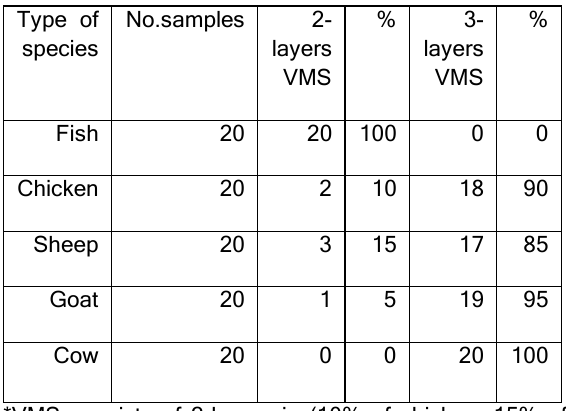
Table 2. Difference in the number of VMS-layers in different species.